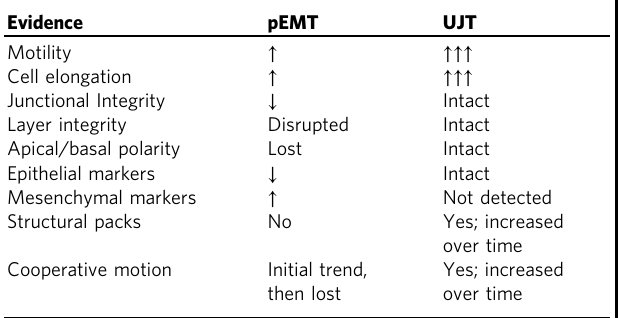
Table 1 Across dynamic, structural, and molecular characteristics, pEMT and UJT are